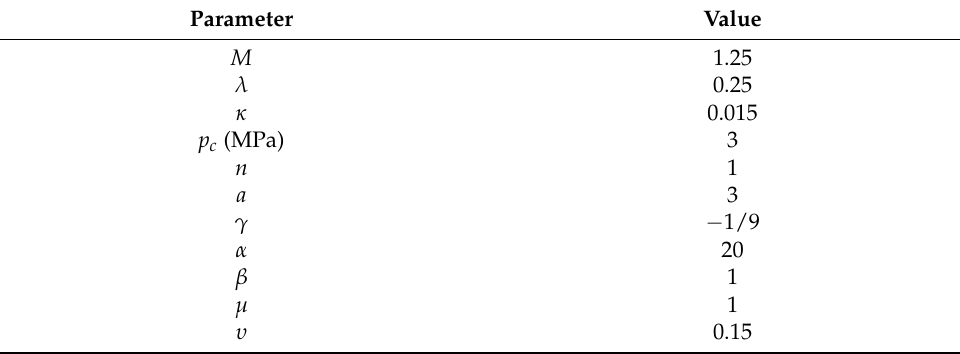
Table A5. Parameters adopted for simulation in Figure